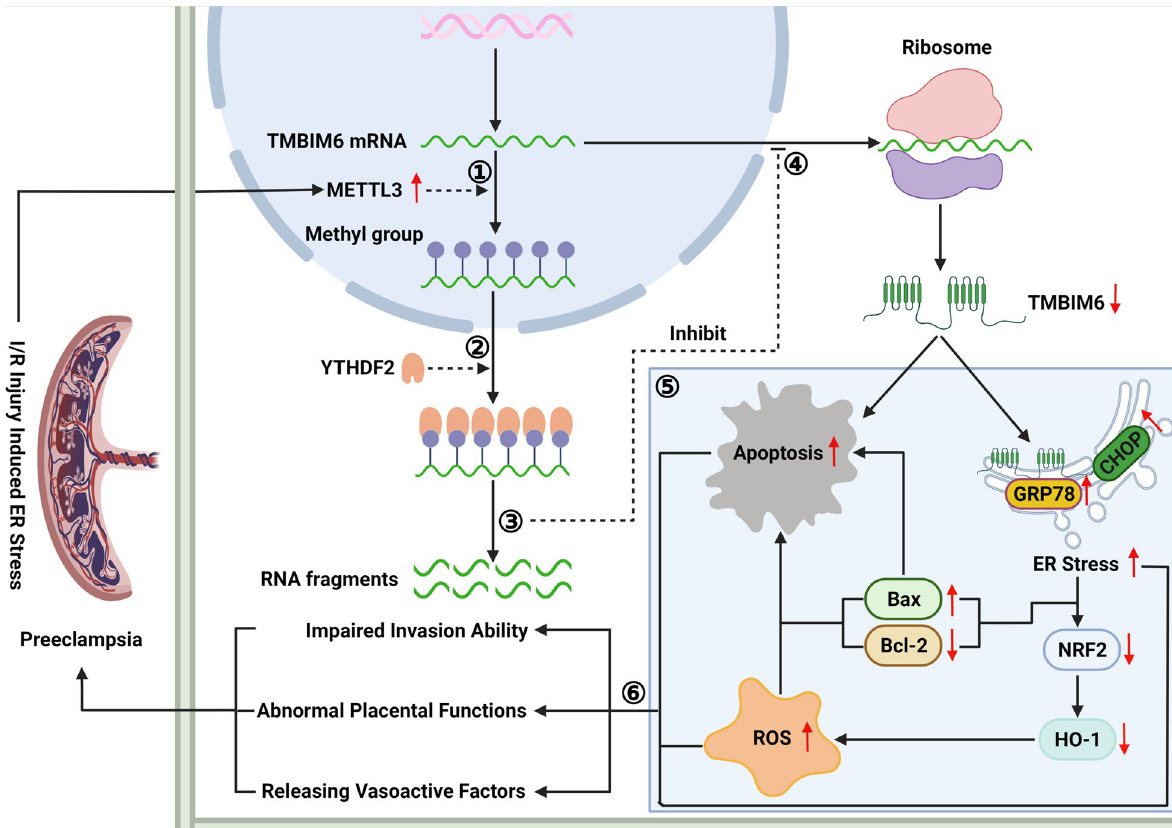
Fig. 9 The schematic of molecular mechanism about how METTL3 affected TMBIM6 expression resulting in trophoblastic dysfunction and PE. ① When placentas got injured by many detrimental factors, such as I/R, the trophoblasts were under ER stress and METTL3 expression was upregulated increasing the m 6 A modification of TMBIM6 mRNA in trophoblasts. ② The methylated TMBIM6 mRNA was recognized by YTHDF2. ③ YTHDF2 decreased the stability of TMBIM6 mRNA and increased its degradation. ④ TMBIM6 expression was downregulated due to the decreased TMBIM6 mRNA and its translation. ⑤ Downregulation of TMBIM6 could not maintain the ER homeostasis, which aggravated ER stress. Moreover, the apoptosis and ROS production were increased when TMBIM6 was decreased. ⑥ The trophoblasts functions were impaired with the placental functions abnormal, which consequently contributed to